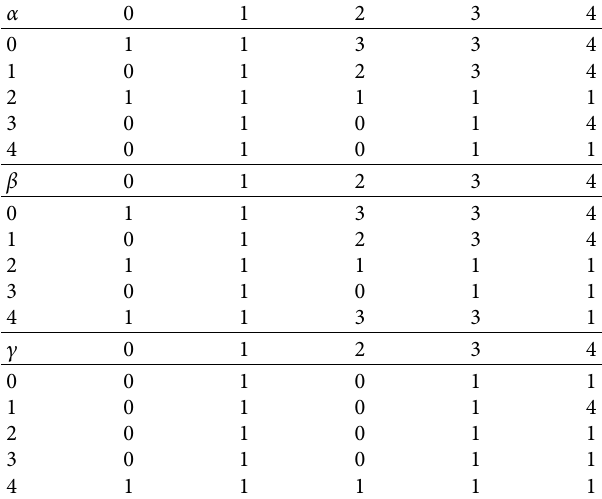
Table 11: Cayley tables for the binary operations “ α , β , and c .”